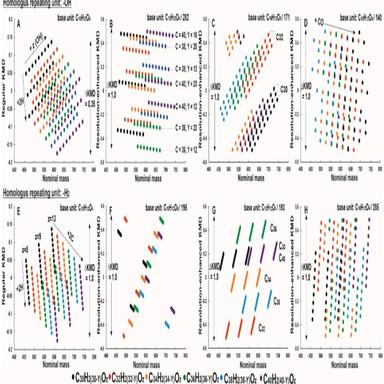
KMD plots for simulated oligomeric structures with homologous repeating units OH (A–D) and H2 (E–H), and C10H12O4/X Kendrick base unit with X = 1 (A, E), 282 (B), 171 (C), 140 (D), 195 (F), 193 (G), and 285 (H).